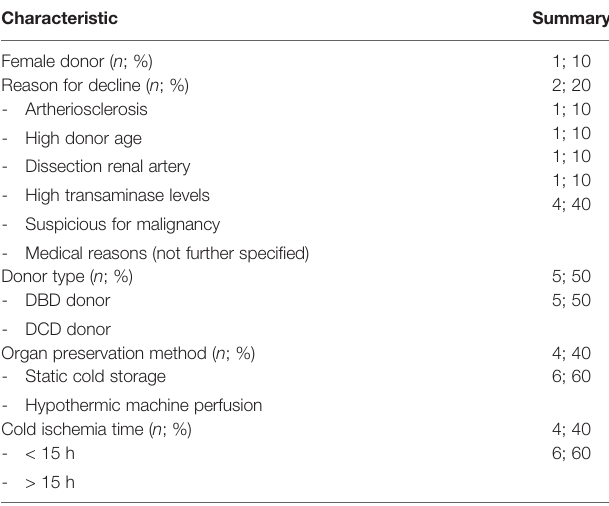
TABLE 3 | Baseline characteristics of human discarded kidneys perfused during 6 h of normothermic machine perfusion. Characteristic